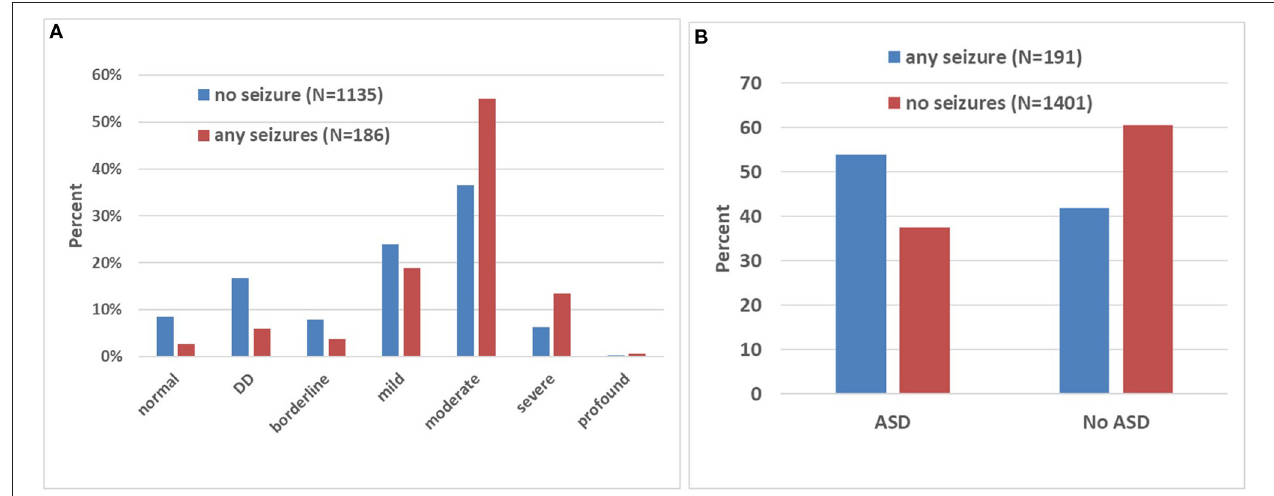
FIGURE 1 | Association between intellectual disability (ID), autism spectrum disorder (ASD), and seizures in FXS. (A) The bar graph depicts the proportion (in percentages) of individuals with and without seizures at each level of ID. Note the higher proportion of patients with seizures at the higher levels of ID severity. DD corresponds to developmental delay in younger individuals. (B) The graph shows the proportion (in percentages) of individuals with and without seizures diagnosed (or not) with ASD. Note in the group with ASD, a higher proportion of patients with seizures.